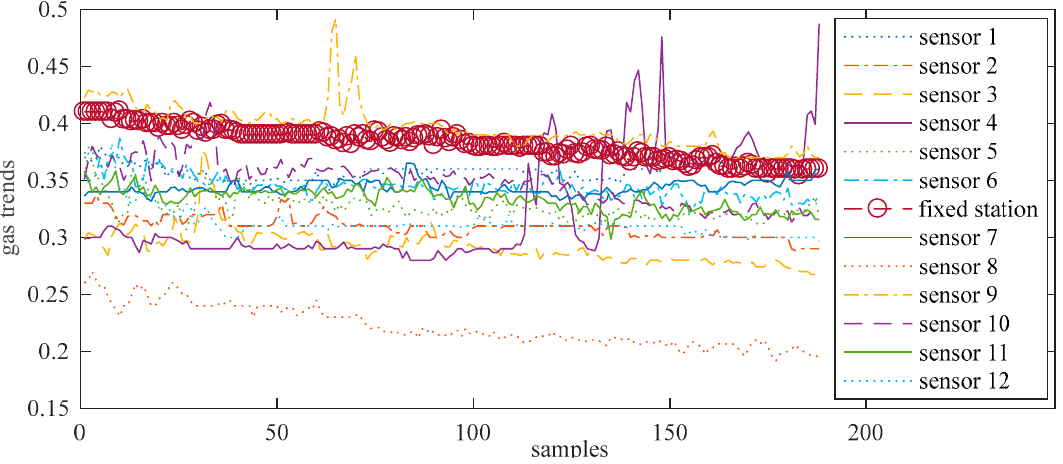
Figure 7. 12 channel test gas signal and fixed gas signal.